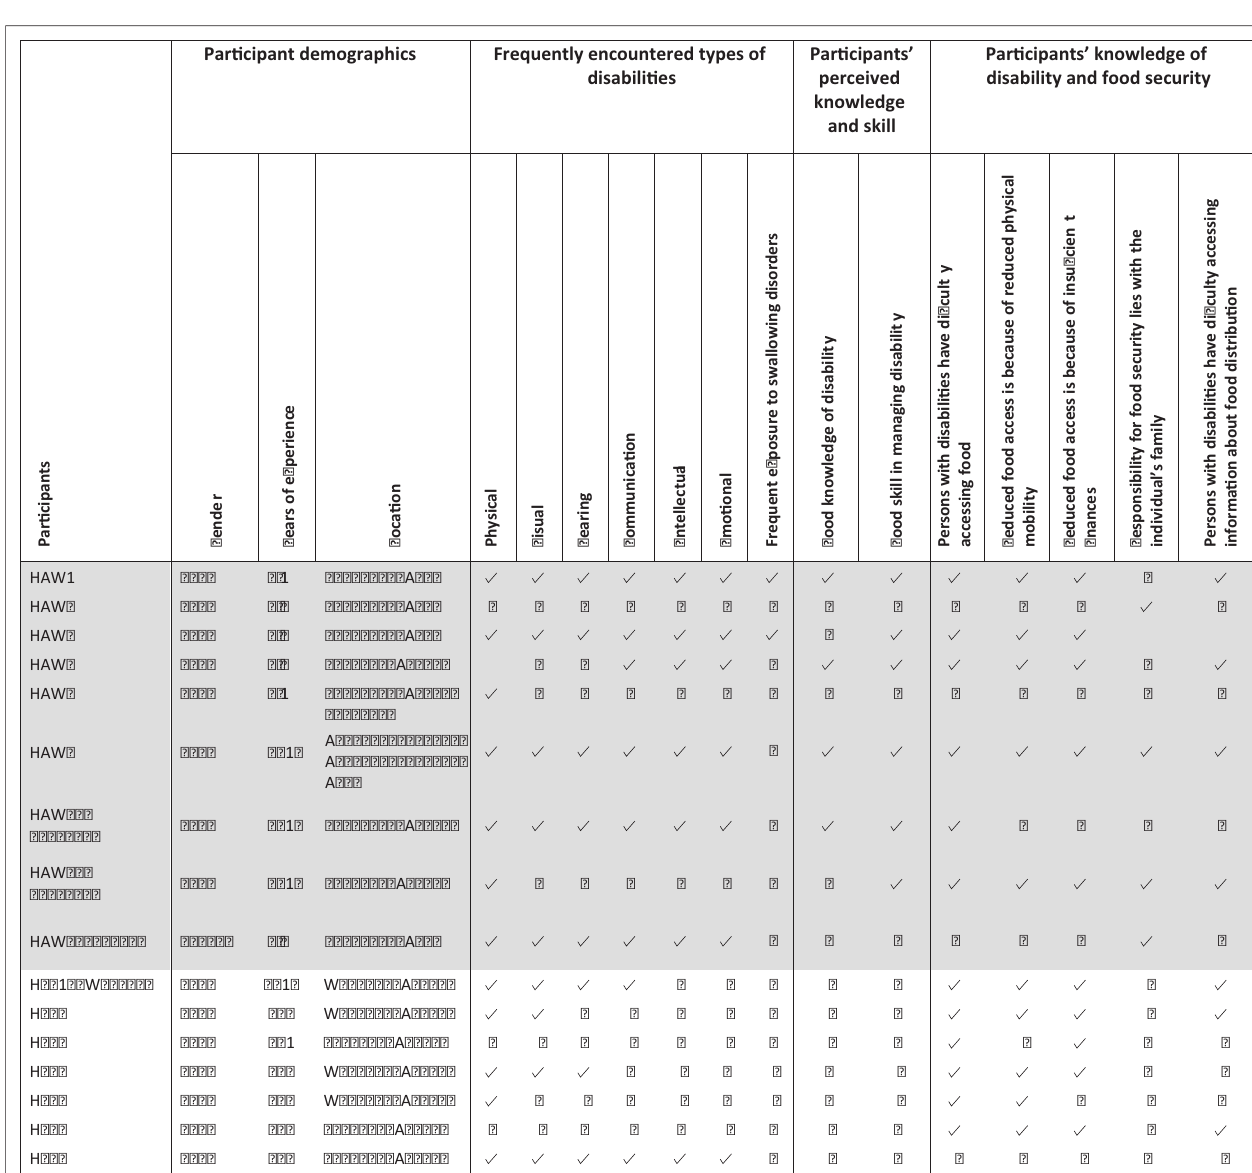
FIGURE 1: A framework for access to food in vulnerable contexts.